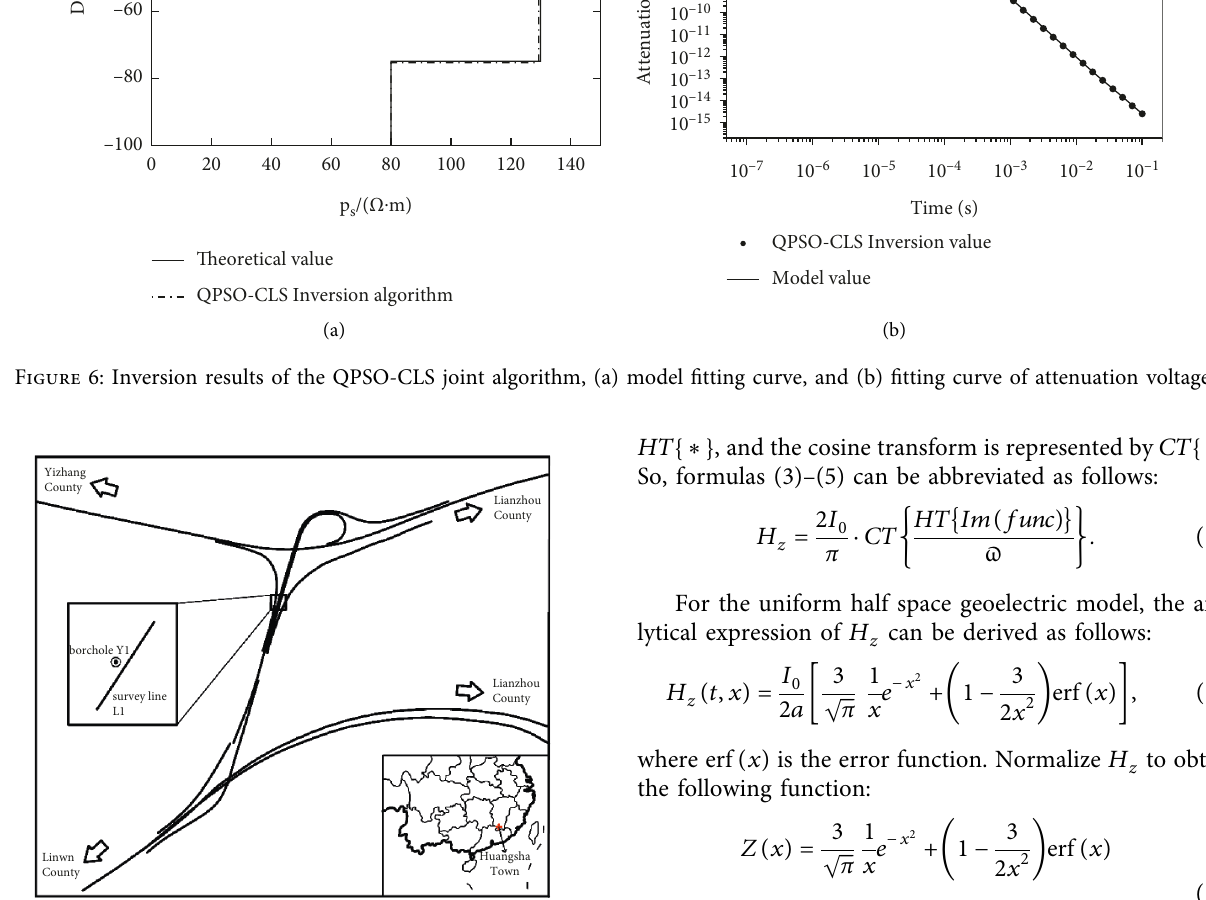
Figure 7: Schematic diagram of work area